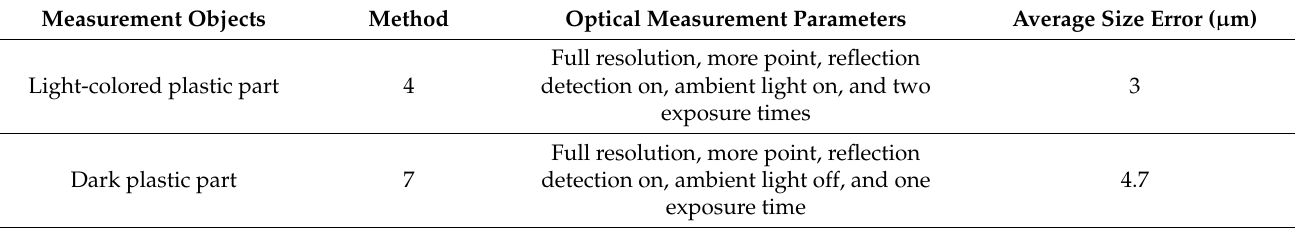
Table 3. An empirical technical database for 3D optical measurement of the object without spraying a mixture of TiO 2 powder and ethanol.